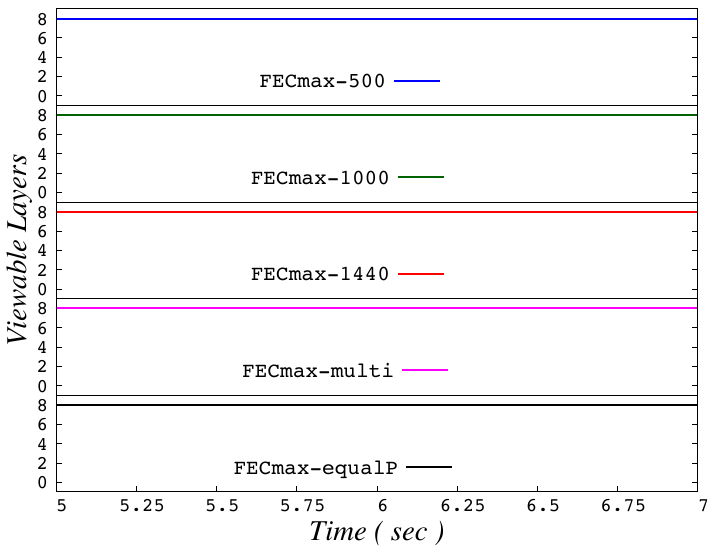
Figure A25. A two-second example of variation in viewable quality for all FEC max models, at a packet loss rate of 10% and a GOP of 32. This illustrates an increase in the FEC max for C1 and C2 based on the worst case scenario, as shown in Table